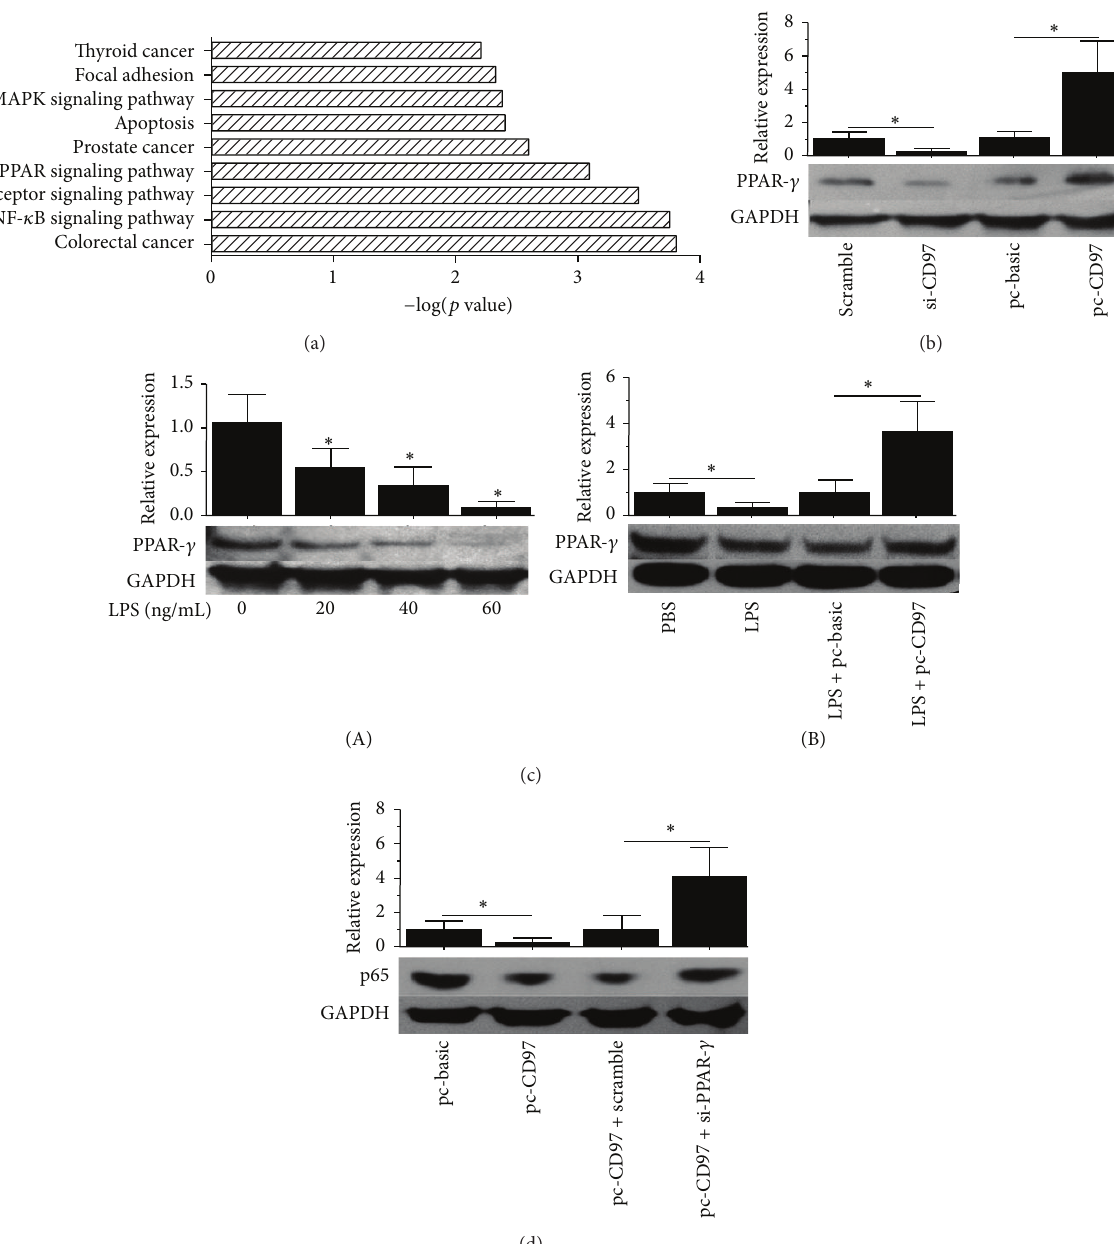
Figure 3: Effect of CD97 manipulations on p65 through increasing PPAR- 𝛾 expression. (a) Pathways analysis when macrophages were transfected with CD97 overexpression plasmids. (b) CD97 ablation inhibited PPAR- 𝛾 protein level while its ectopic expression increased it. (c) LPS inhibited PPAR- 𝛾 protein levels in a concentration dependent gradient (from 0 to 60 ng/mL) (A). CD97 ectopic expression rescued LPS induced PPAR- 𝛾 inhibition (40ng/mL) (B). (d) CD97 induced p65 inhibition was rescued by PPAR- 𝛾 ablation by